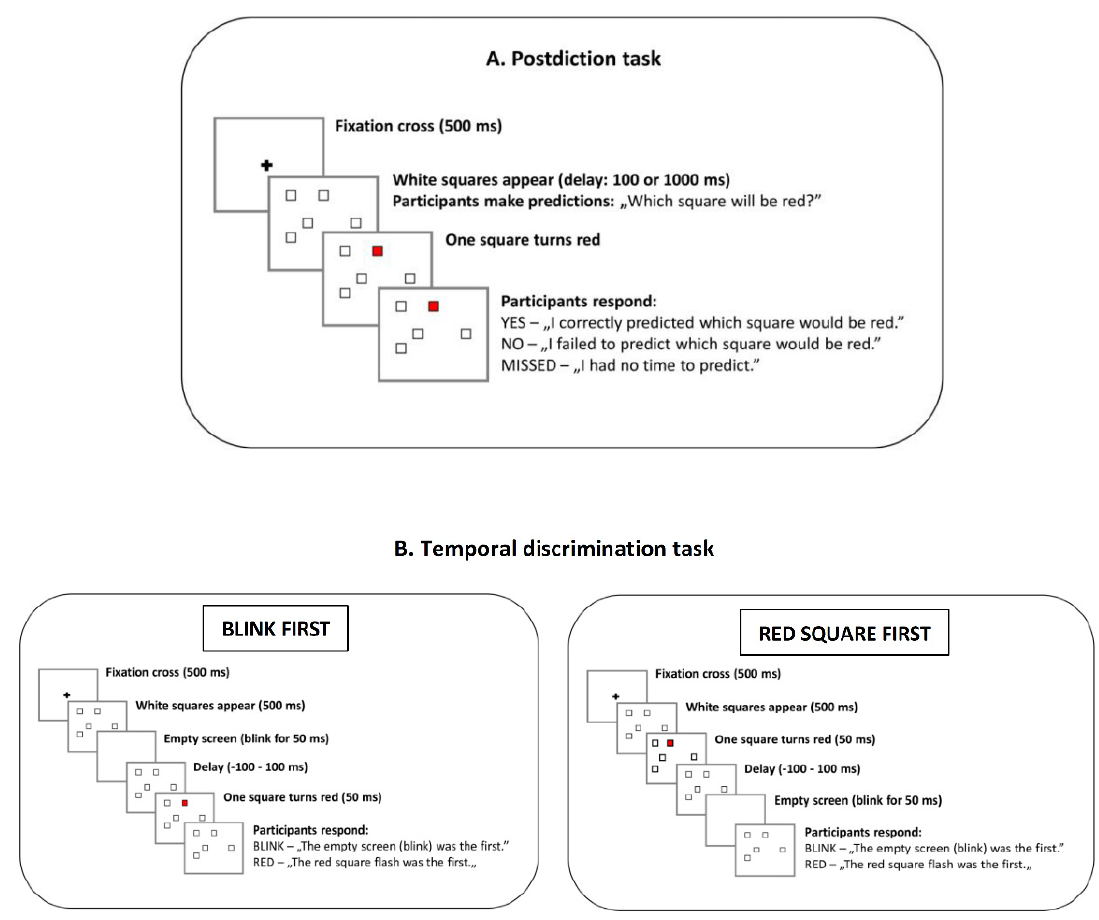
Figure 1. Postdiction task ( A ). Five empty squares were presented on the display. Participants predicted which of the five squares would turn red. Temporal discrimination task ( B ). After presenting the five squares, the screen blinked (blink first), or one of the squares turned red (red square first). Participants indicated whether they observed the blink or the flashed red square first. Following the literature convention, negative delay ( − 100 ms) refers to the case when the red square is the fi rst.